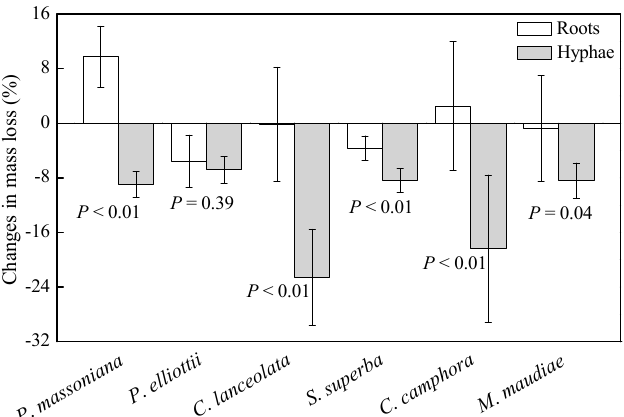
Figure 6. Changes in root litter mass loss induced by the presence of living roots (Roots) and mycorrhizal hyphae (Hyphae). p -values were obtained from linear mixed models conducted separately for each tree species, which were performed to analyze whether living roots significantly di ff ered from mycorrhizal fungi in their e ff ects on mass loss. Error bars represent 95% confidence intervals (CIs). When 95% CIs do not overlap with y = 0, the presence of living roots or mycorrhizal hyphae significantly a ff ects root litter mass loss.